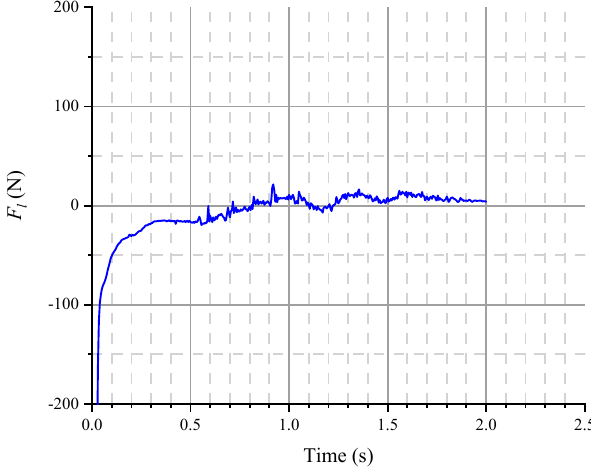
Figure 20. Convergence process of cruising lift.